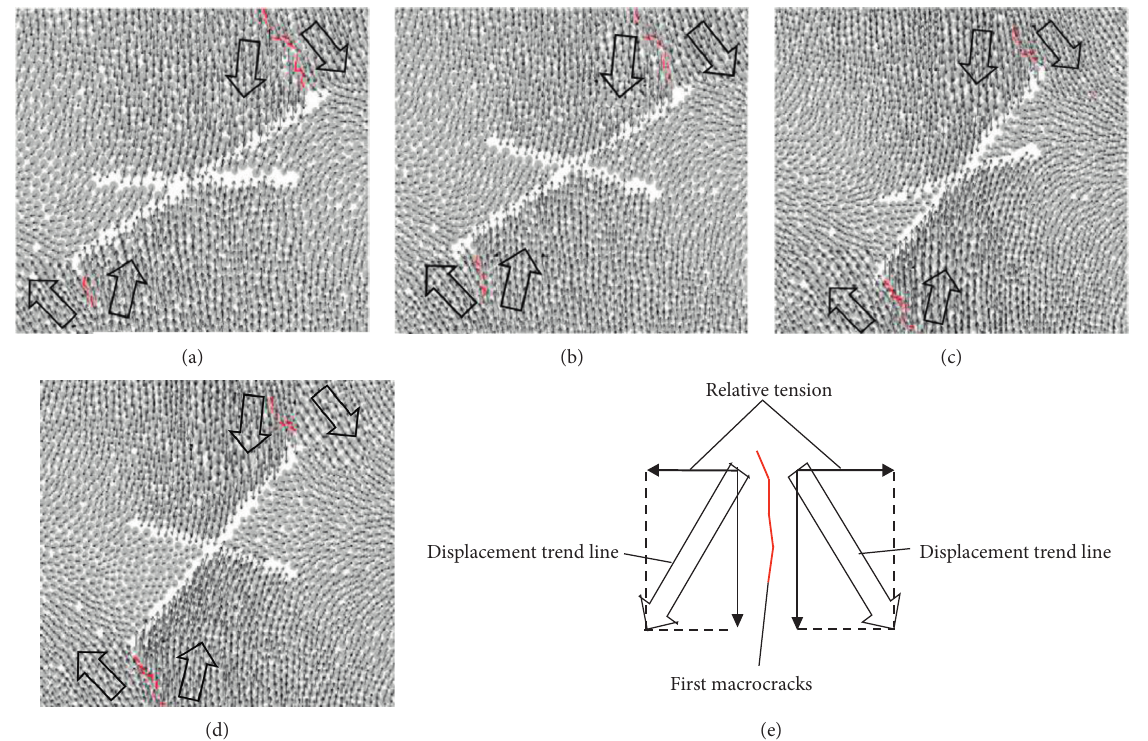
Figure 9: Typical microdisplacement field distributions and of displacement-filed model of granite specimens. (a) α � 30 ° and β � 30 ° , (b) α � 30 ° and β � 45 ° , (c) α � 45 ° and β � 30 ° , (d) α � 45 ° and β � 60 ° , and (e) displacement-filed